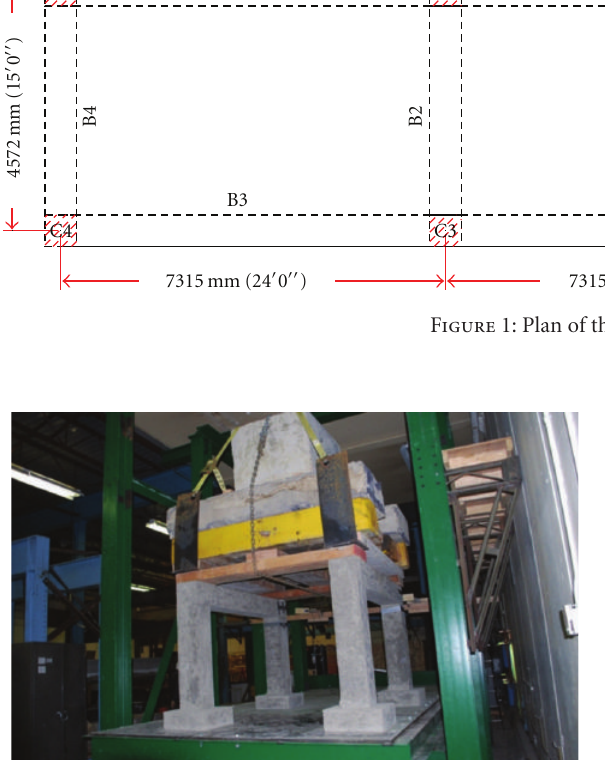
on reinforced concrete fly ash concrete beams and slabs containing normal weight aggregates and light weight aggre- gates. The results of their tests showed that concrete